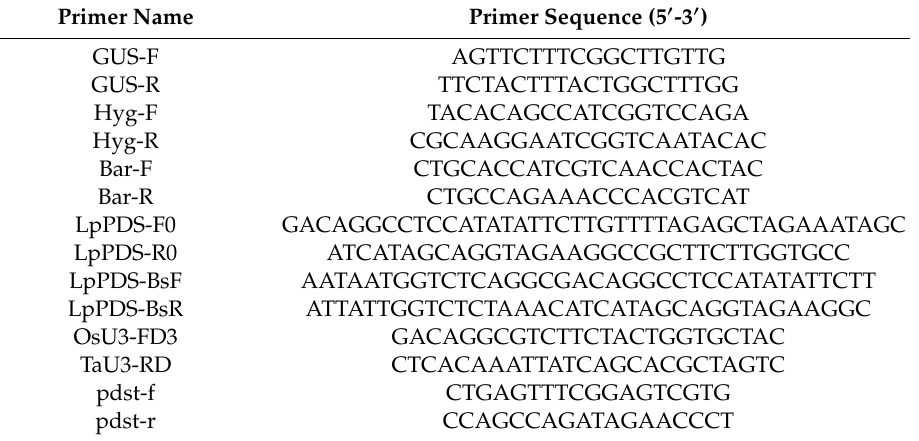
Table A2. Primers used in the